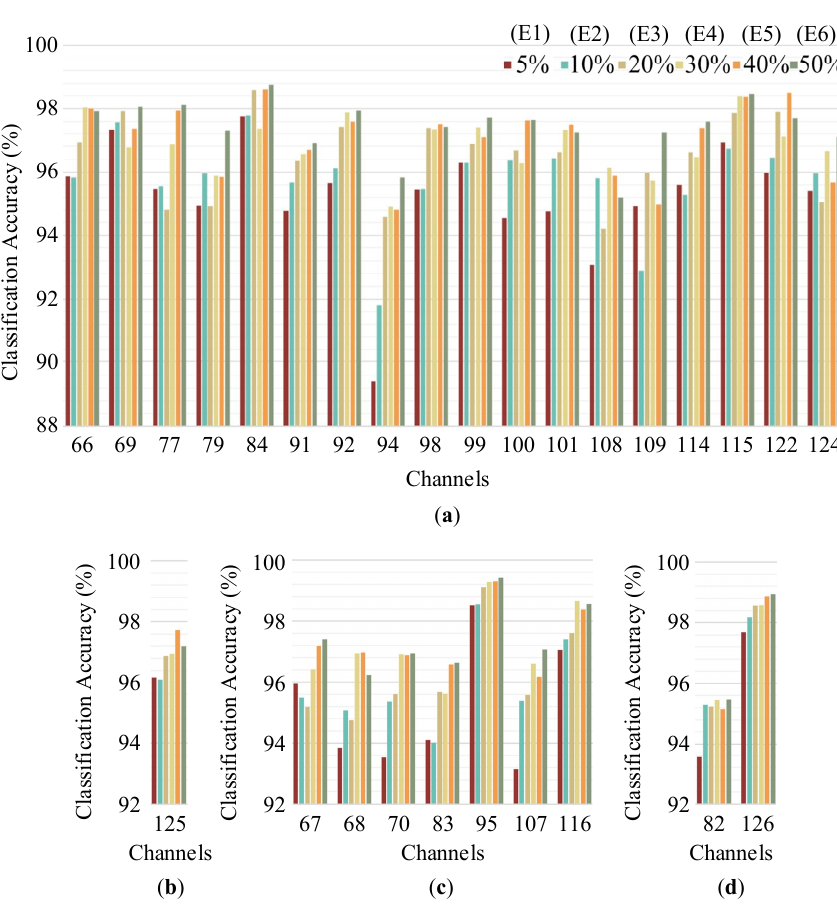
Figure 9. Classification accuracies of the recording channels with different numbers of spike clusters: ( a ) Three clusters; ( b ) two clusters; ( c ) four clusters; ( d ) five clusters.